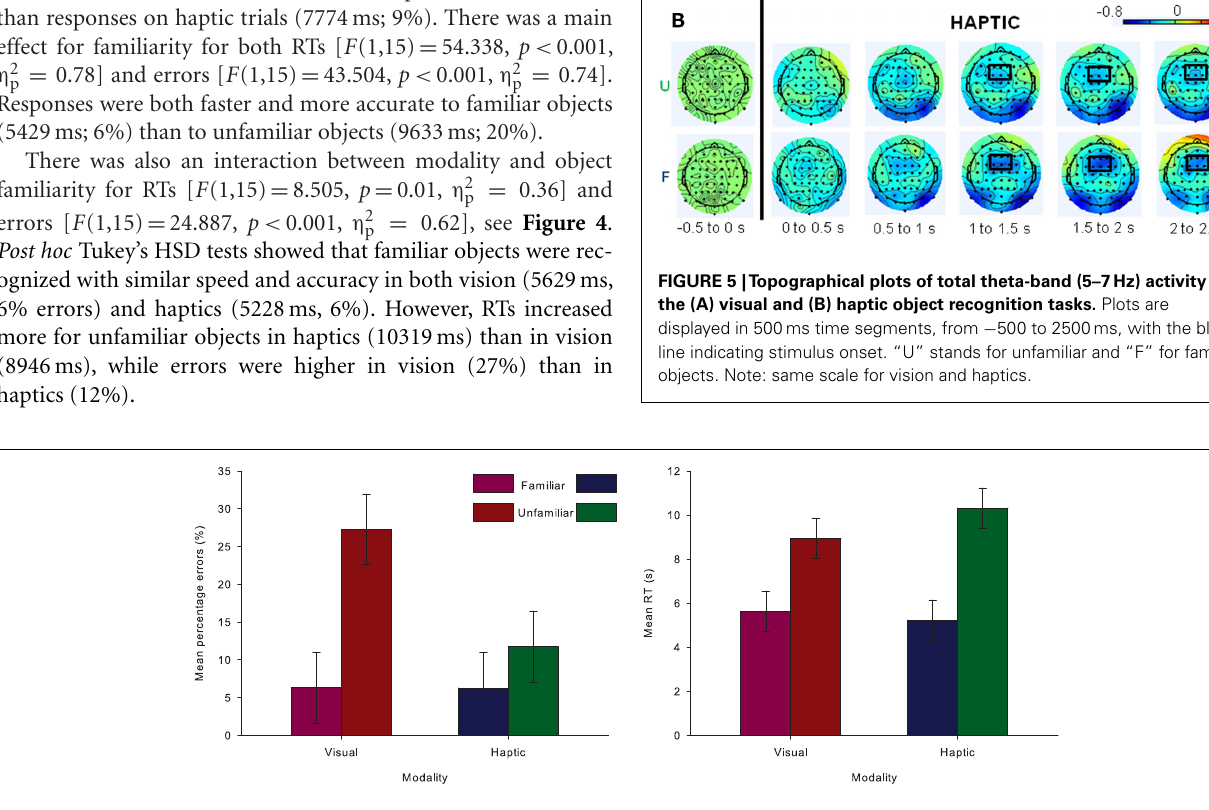
within-participant confidence intervals based on the MSE of the interaction between modality and object familiarity (Jarmasz and Hollands,